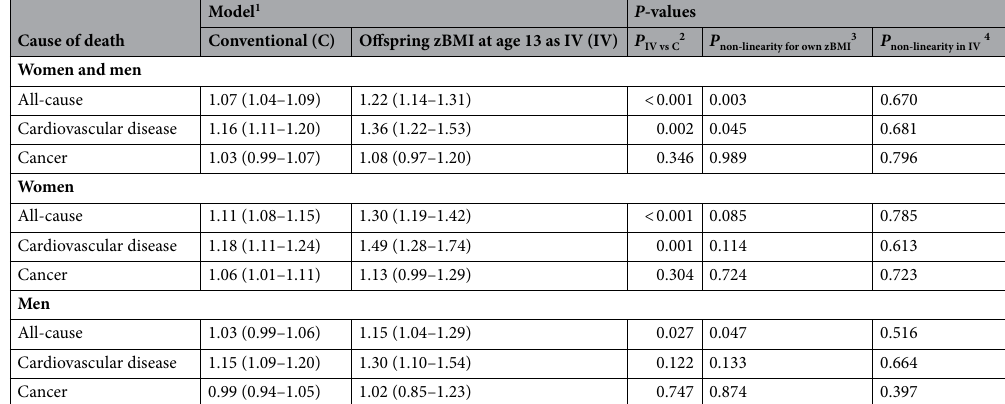
Table 3. Associations between zBMI at age 13 and adult mortality: hazard ratios (95% confidence intervals) per zBMI estimated from conventional analyses of own zBMI and from analyses using offspring zBMI at age 13 as instrumental variable (IV). 1 Adjusted for offspring and parental birth cohort, parental and offspring zheight and parental sex. 2 P -values from Durbin-Wu-Hausman test. 3 P -values from a Wald test of non-linearity in the conventional association. 4 Linear trend test from a meta-regression of stratum specific IV estimates on the stratum-specific mean zBMI. BMI body mass index, IV instrumental